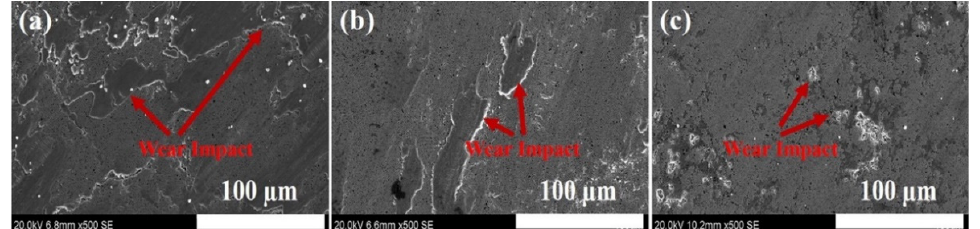
Figure 6. SEM images for the wear track of the Ni-W/B composite coatings fabricated at 75 °C, 5 g/L boron concentration, 0.1 A/cm 2 current density and 8.9 pH at various heat treatment temperatures ( a ) as-deposited, ( b ) 300 °C, ( c ) 600 °C.